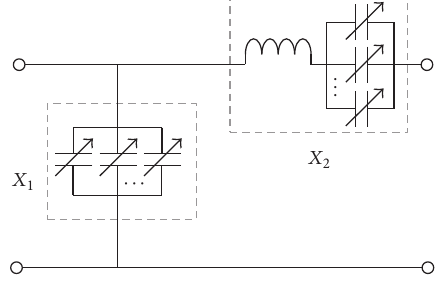
Table 2: Measured parameters of the experimental WPT